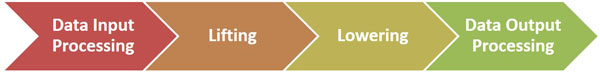
Connector implementation functional blocks. An arrow represents an implementation functional block. The left to right serial disposition of the arrows indicates the order in which each functional block should be executed, starting at the Data Input Processing block.